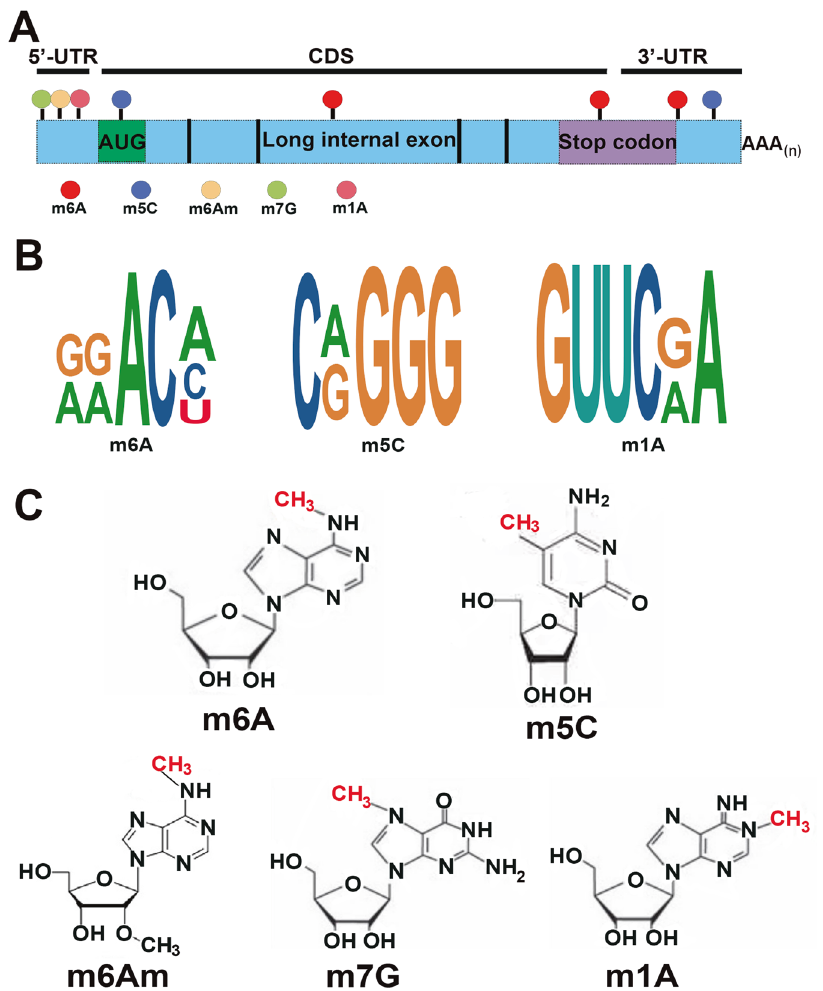
Fig. 1 Distribution and molecular structures of RNA methylations. A Schematic representation of the distribution of m6A, m5C, m7G, m1A, and m6Am in the mammalian transcriptome. The m6A modi fi cation is generally enriched in long internal exons, stop codons, and 3 ʹ -UTR. B The motifs of m6A, m5C, and m1A are conserved. C Molecular structures of RNA methylation: m6A, m5C, m6Am, m7G, and